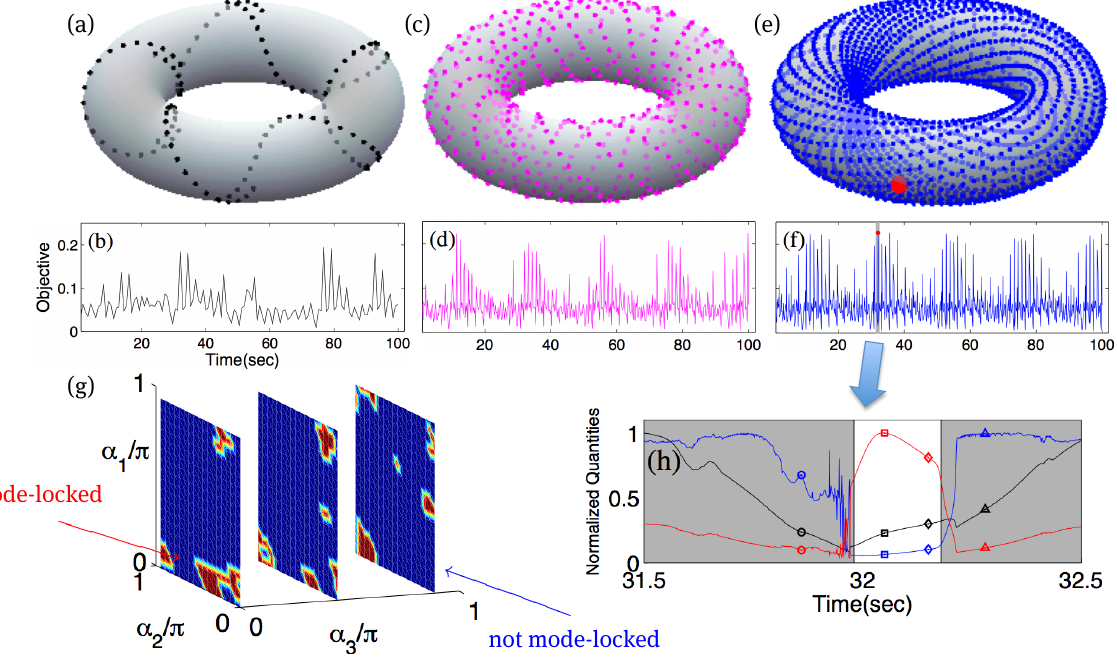
Figure 4: Visualization of the toroidal search algorithm with a waveplate and the polarizer. (a, c, e) 2-torus of α 3 and α p with sample points shown (dots) for different sample rates ( 1.25 Hz-black, 5 Hz-magenta, 20 Hz-blue, the global optimum is marked in red). (b, d, f) The time- series of the corresponding objective function with the global optimum again marked in red. (h) Zoomed in objective function (red) plot near the global optimum, pulse energy (black) and kurtosis (blue) are also shown (all normalized to the same scale for comparison). (g) Experimental confirmation of the approach as given in Refs. [7, 8]. The red patches are experimentally determined mode-locked states while the blue regions are not